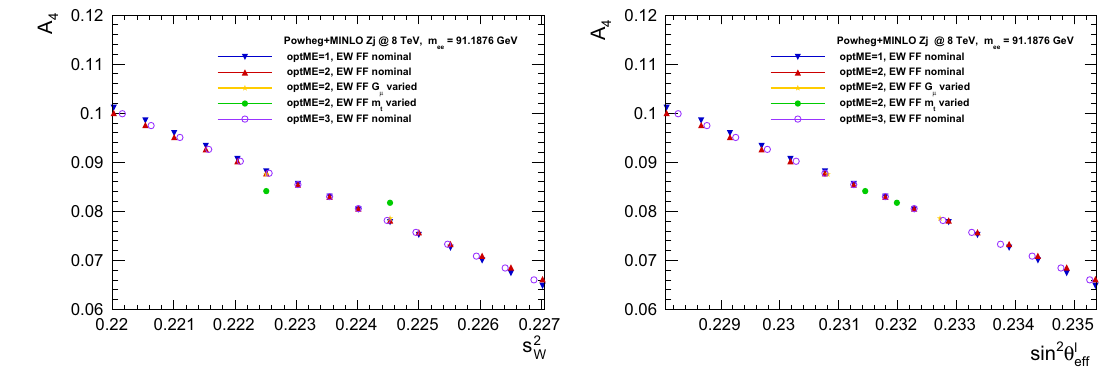
Fig. 9 The A 4 variation due to shifts induced with the presented in Appendix B options; as a function of s 2 sin 2 θ l (right-hand side). The “FF G μ varied”, FF m t varied” correspond to the case when form-factors were recalculated. Otherwise they were ef f kept at nominal values